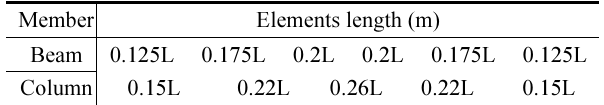
Table 2. Assumed element